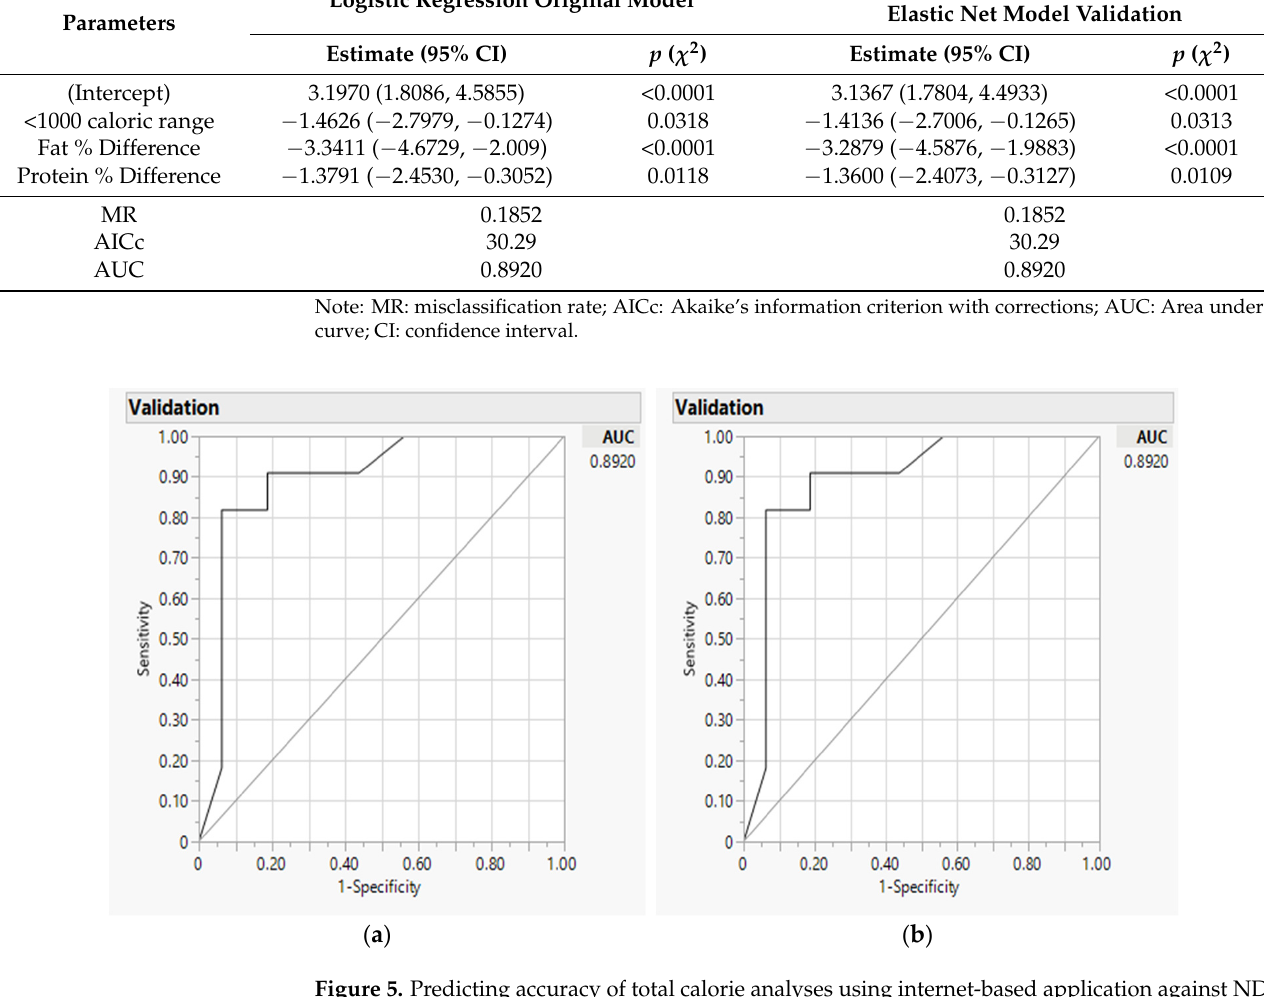
Figure 5. Predicting accuracy of total calorie analyses using internet-based application against NDSR: Area under the receiver operating characteristic curve (AUC) for baseline logistic regression model ( a ) and Elastic Net with validation model ( b ).